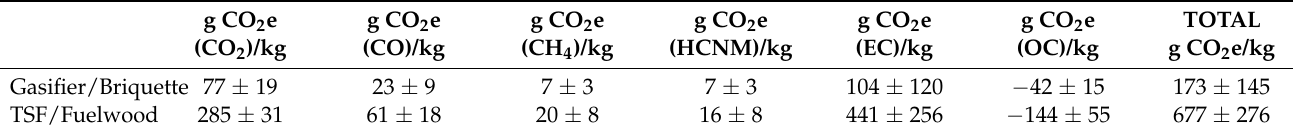
Table 5. CO 2 e /kg dry fuel consumed per pollutant.